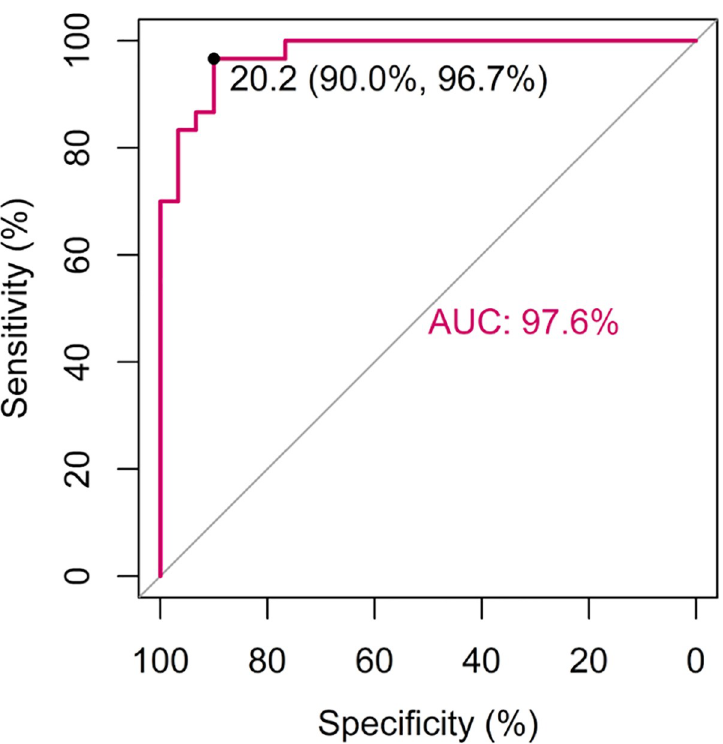
Fig 3. ROC/AUC and best cut-of-value of the HpAfr-ELISA assay in the training set. The plot displayed on this figure represent the ROC ( receiver operating characteristic) and the AUC ( Area under the ROC Curve) obtained with HpAfr-ELISA on the training set using the H . pylori status by standard invasive tests (i . e ., histology , culture , and rapid urease test) as reference . This plot indicates that the ROC curve of HpAfr-ELISA had an AUC of 97.6% with its best cut-of-value being 20.2 U/mL of anti -H . pylori